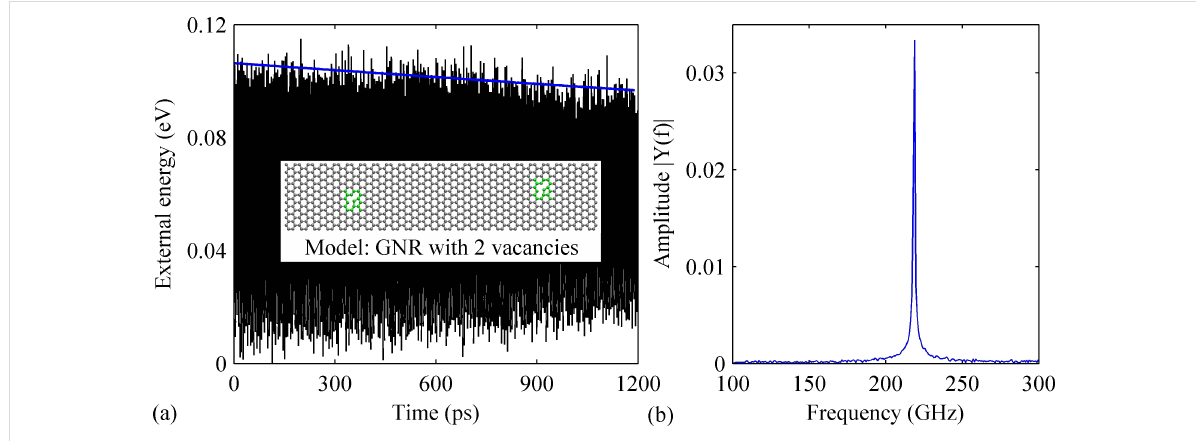
Figure 5: (a) Variation of the external energy over time obtained for a pristine GNR with two vacancies. The inset shows the corresponding model of the GNR. The regions highlighted in green represent the vacancies. (b) The corresponding frequency spectrum.